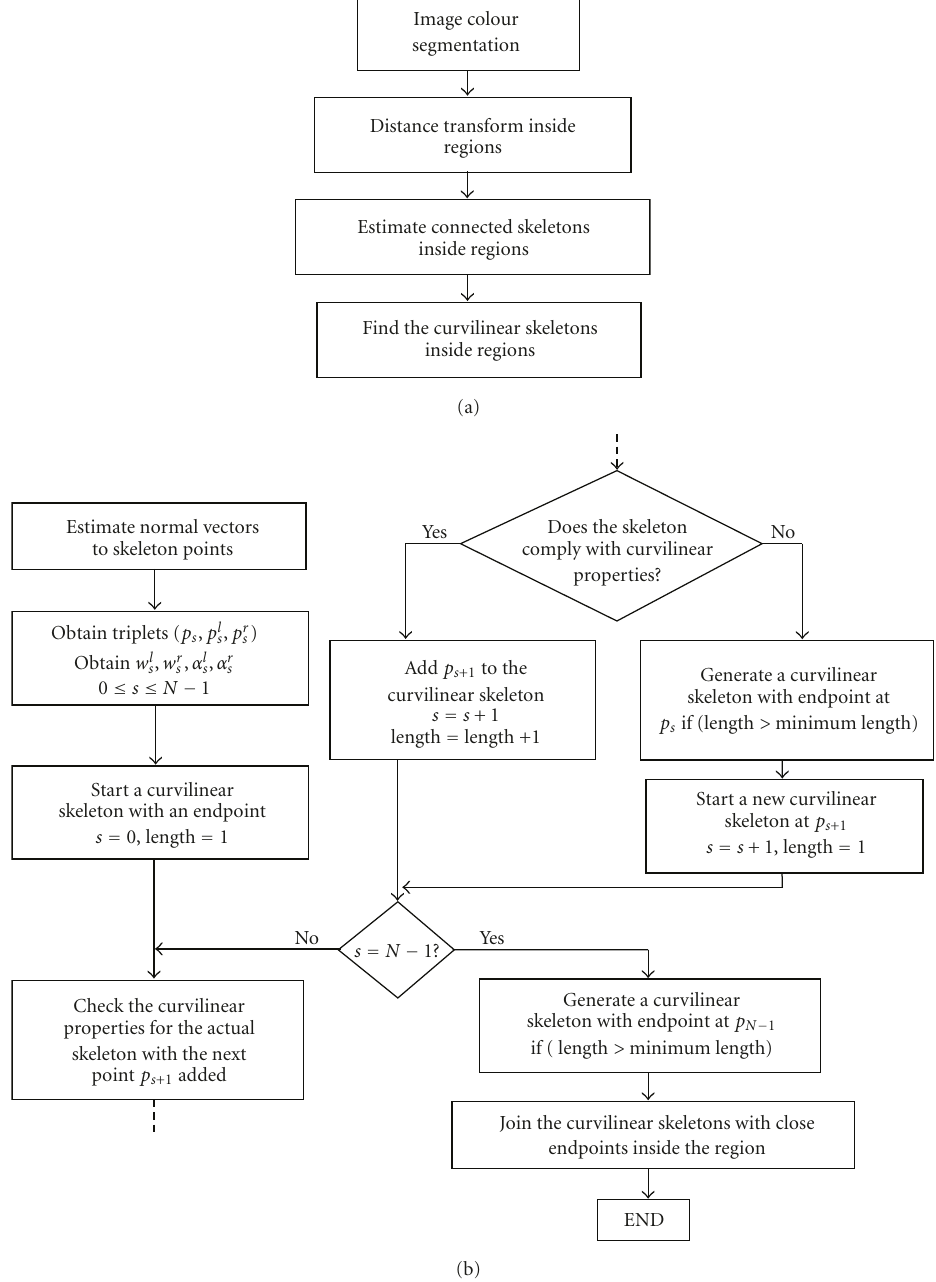
Figure 3: (a) An overview of the method. (b) Algorithm to detect the skeletons with curvilinear properties inside a region. Note that several curvilinear skeletons could be detected inside an homogeneous colour